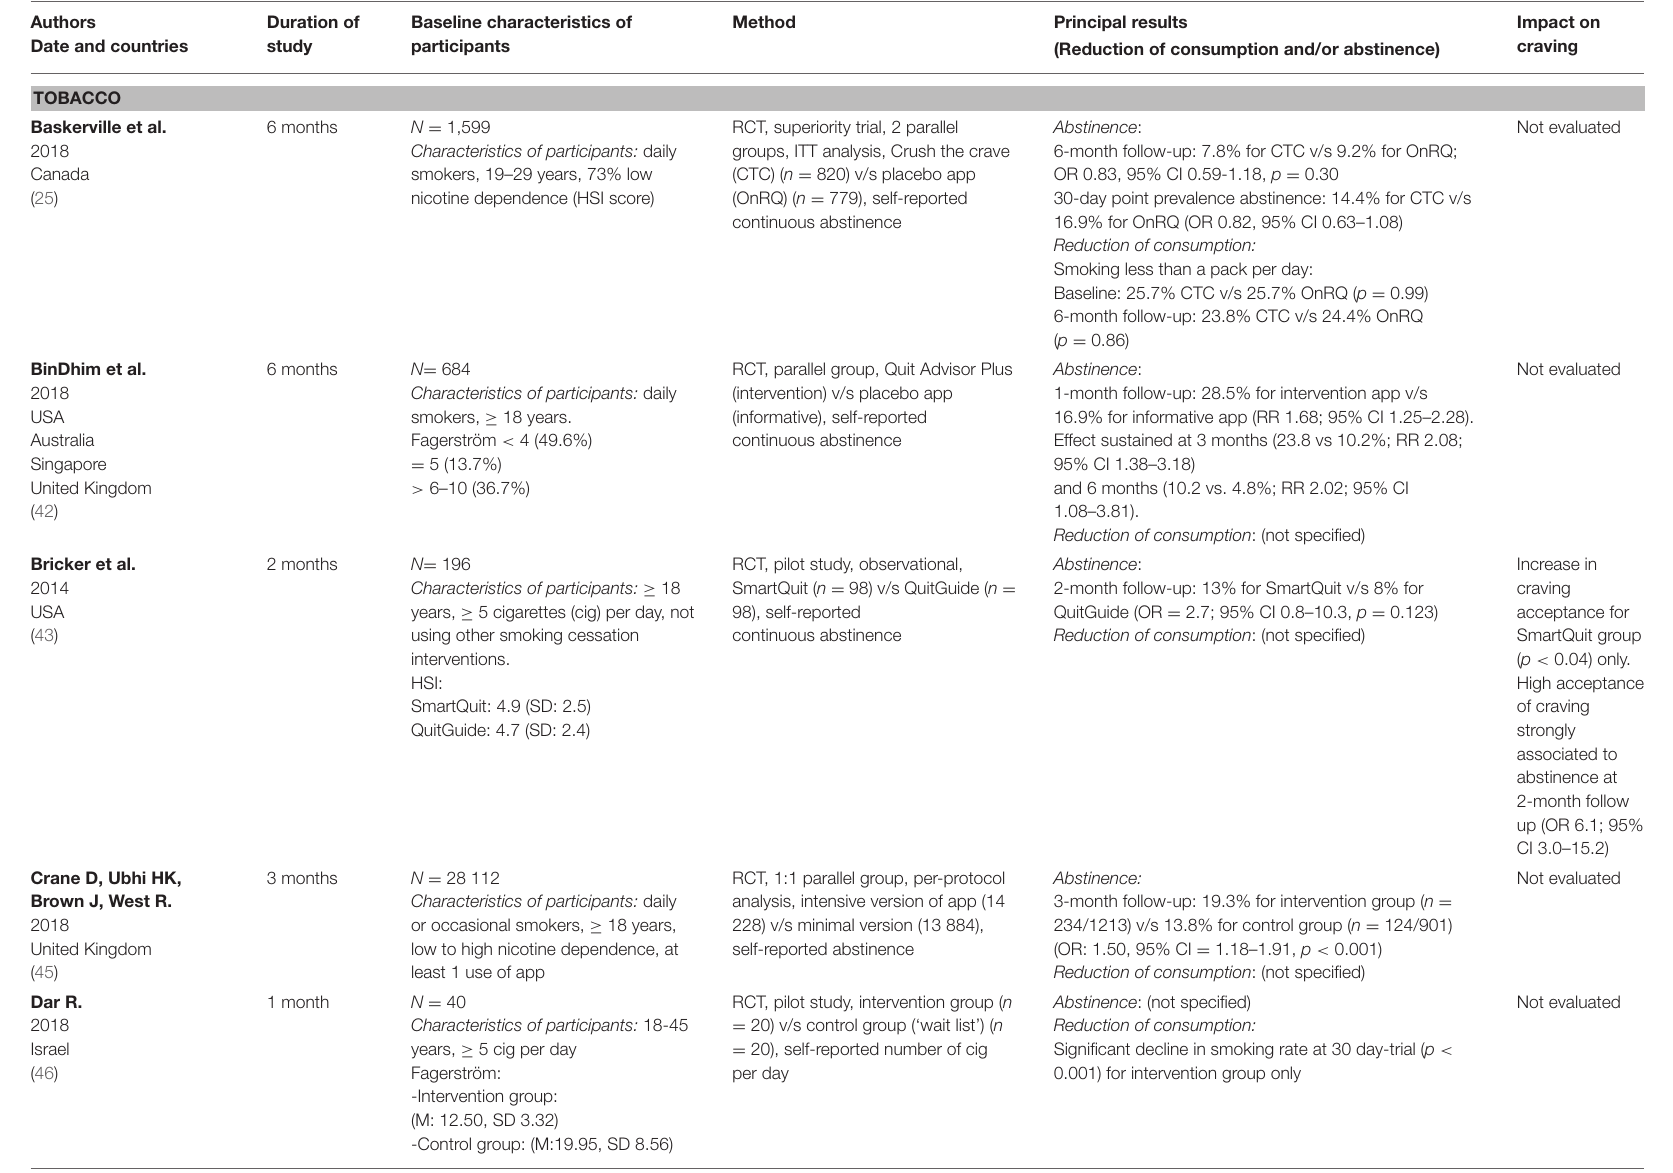
TABLE 3 | Characteristics of controlled trials (ranged by addictive